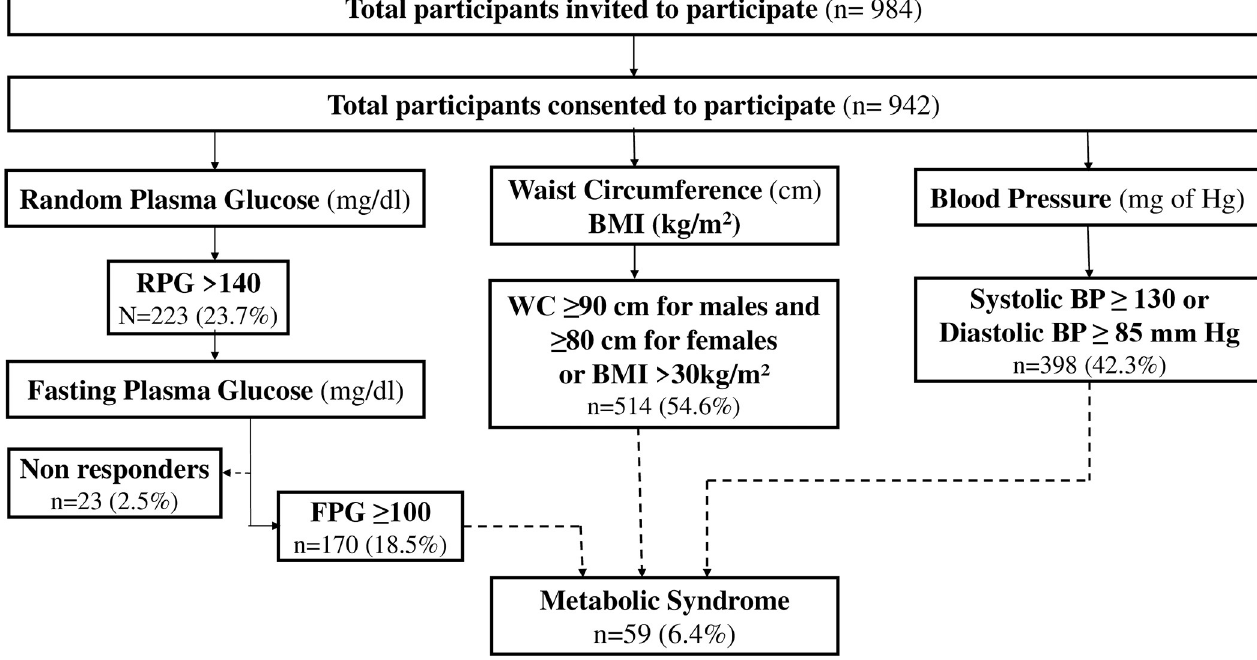
Fig 1. Flow chart depicting screening of the study participants for Metabolic Syndrome.